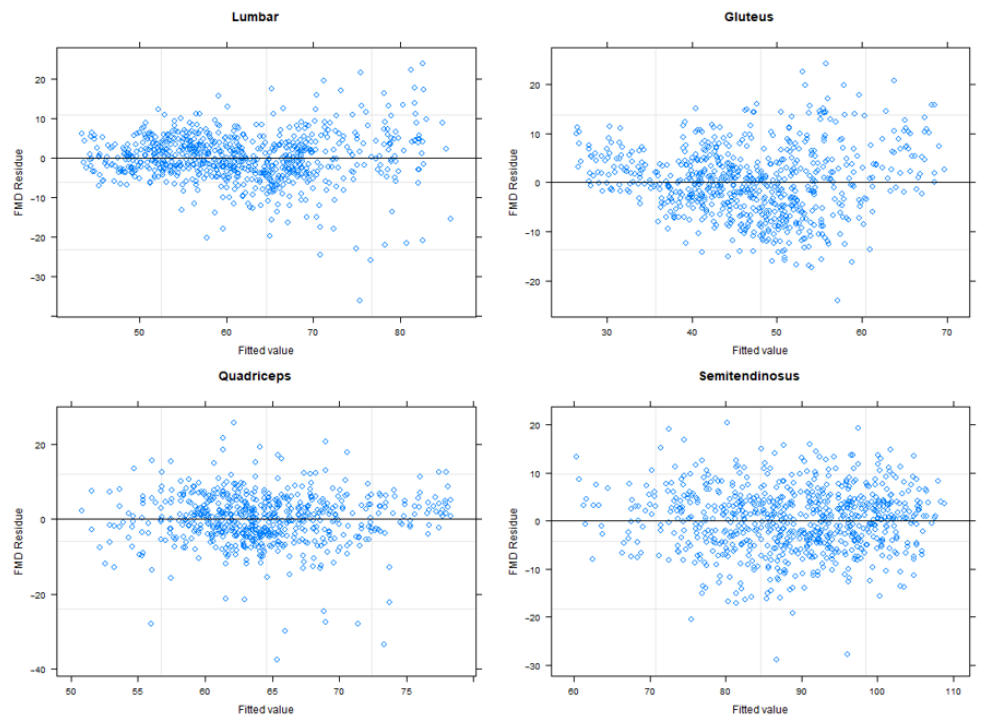
Figure A4. Plot of residues, fitted values minus observed values, over the fitted values for FMD for each muscle mixed